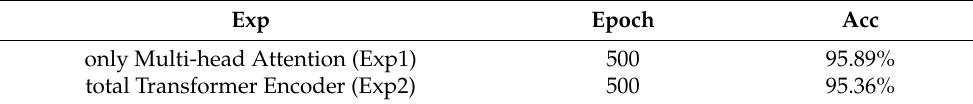
Table 9. Branching experiments.